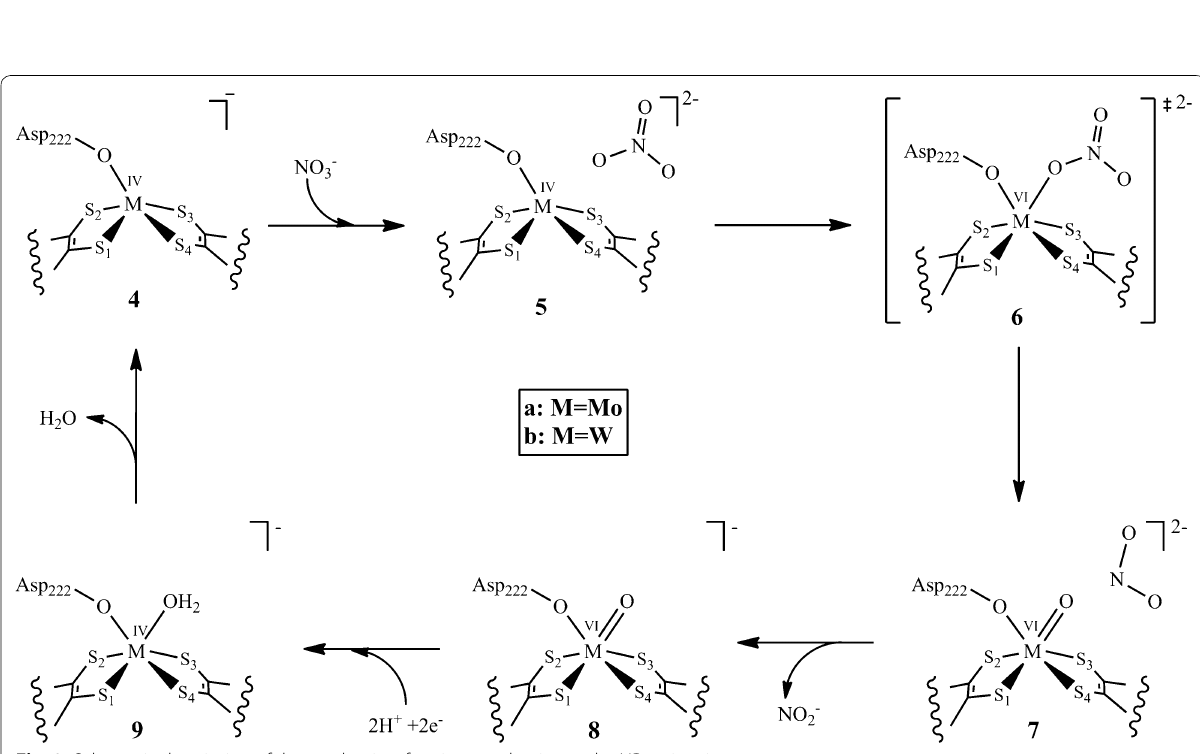
Fig. 8 Schematic description of the mechanism for nitrate reduction at the NR active